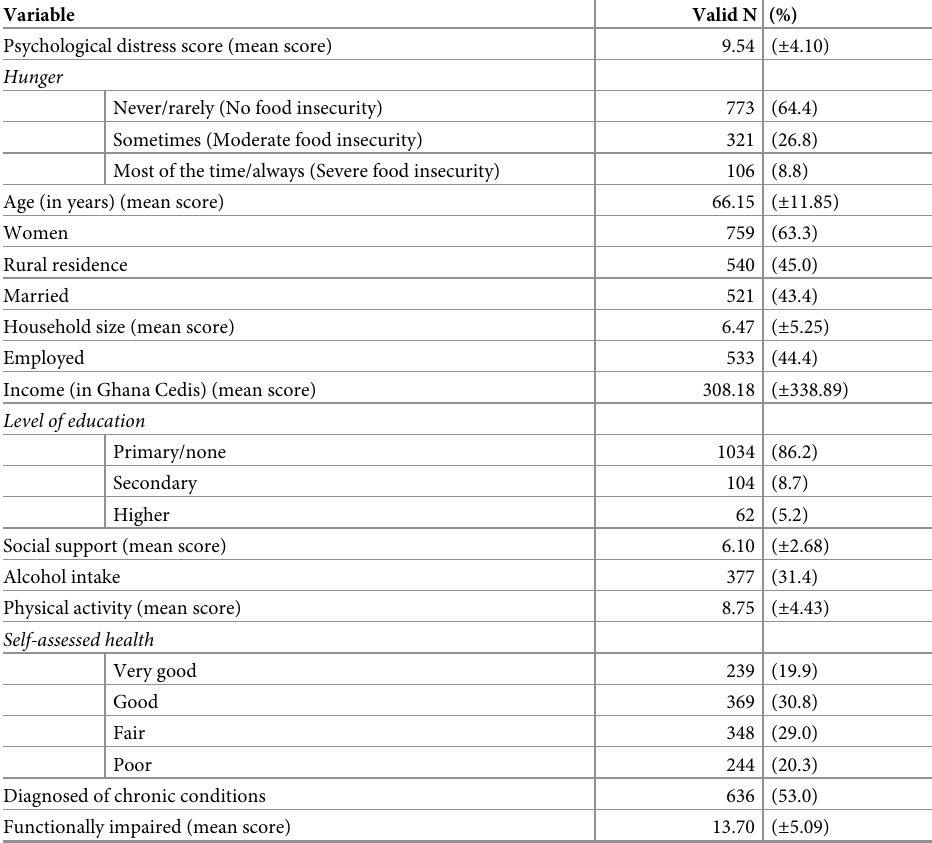
Table 1. Descriptive statistics of the study